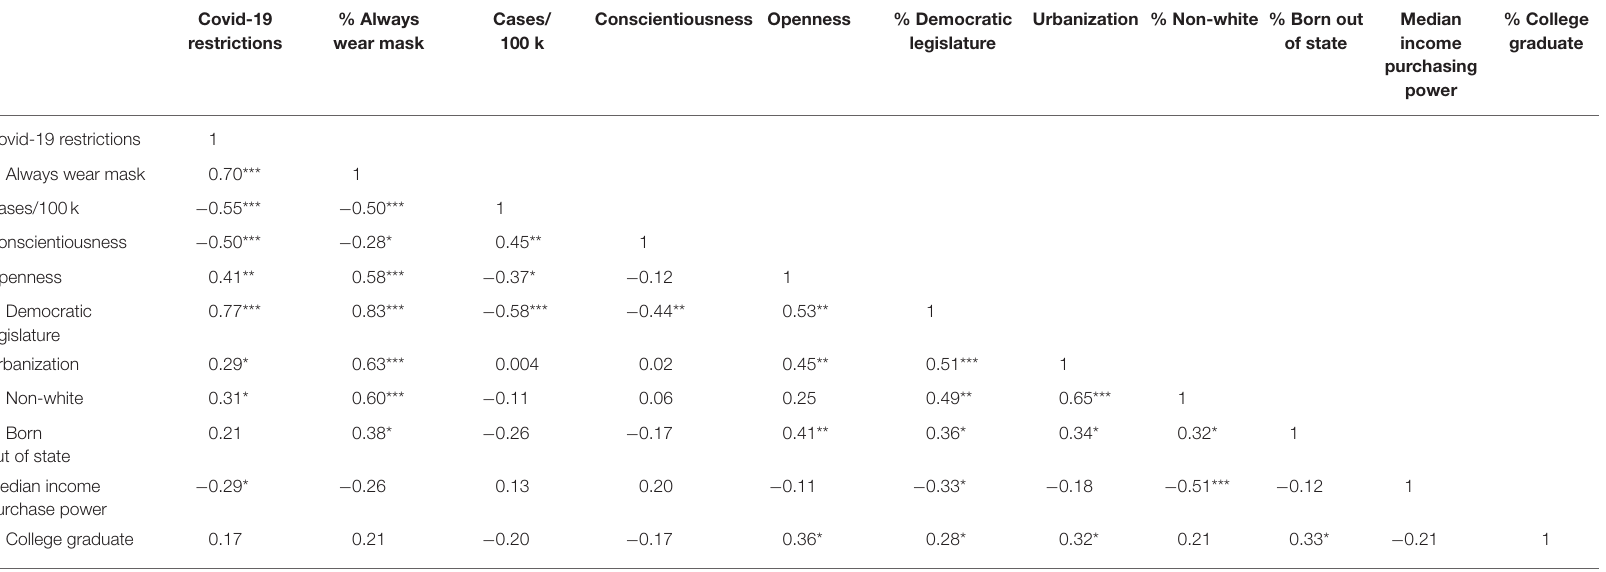
TABLE 2 | Bivariate